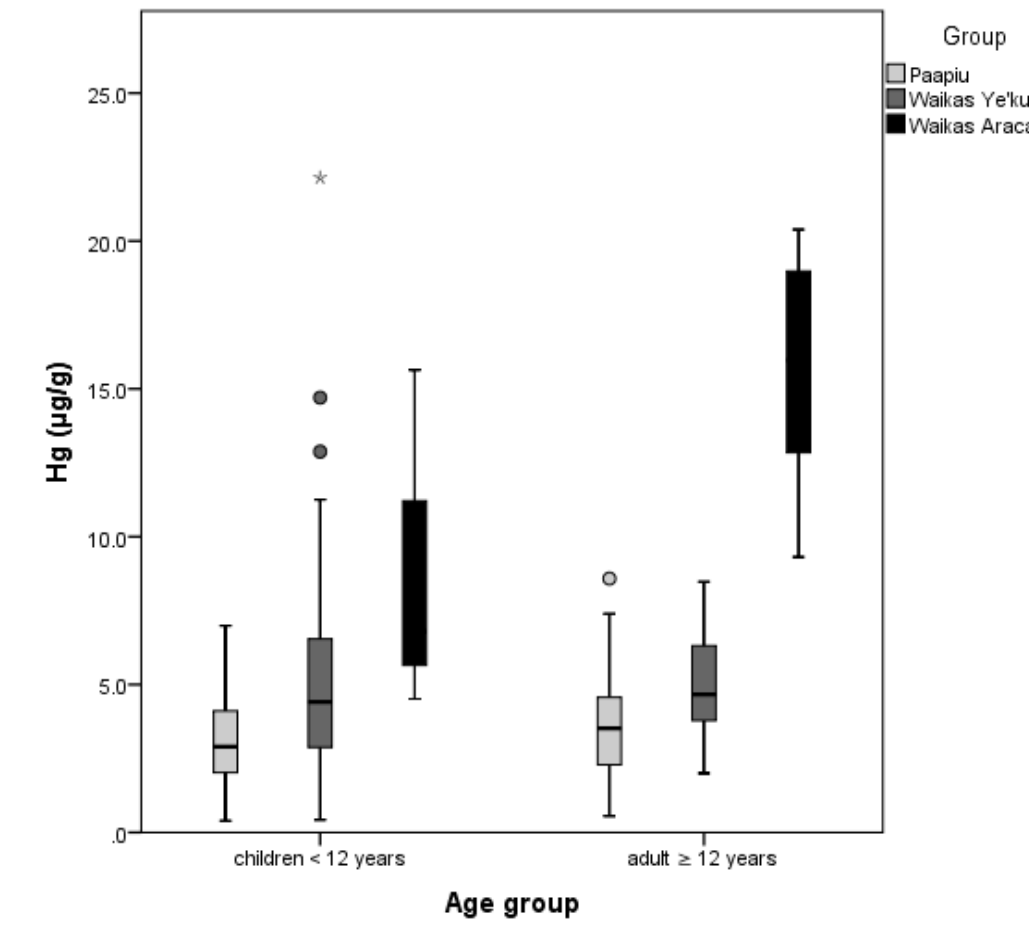
Figure 3. Distribution of total mercury concentrations ( µ g · g − 1 ), according to age groups and villages, Yanomami reserve, Roraima, Amazon, Brazil, 2014.